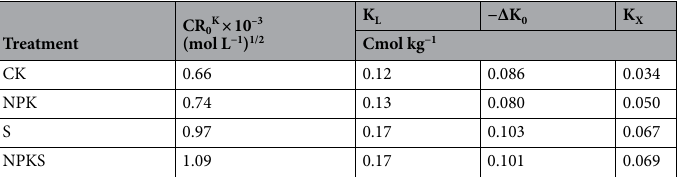
Table 3. Equilibrium K concentration ratio (CR 0K ), labile K (K L ), nonspecifically available K (− ΔK 0 ) and specifically available K (K